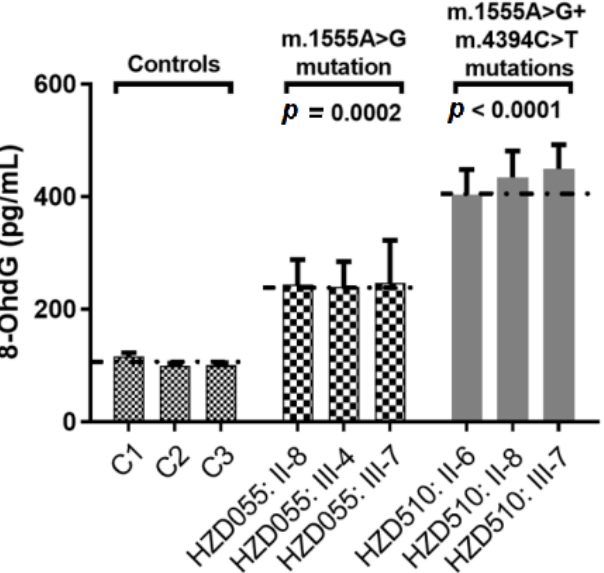
Figure 10. Qualification of serum 8-OHdG levels in three patients with both the m.1555A>G and m.4394C>T mutations, three patients with only the m.1555A>G mutation and three controls. 3.11. Mutational Screening for Common Deafness-Associated Nuclear Genes To uncover the roles of nuclear gene mutations in deafness, we screened for the mu- tations in common deafness-associated genes ( GJB2 , GJB3 , GJB6 SLC26A4 and TRMU ) in